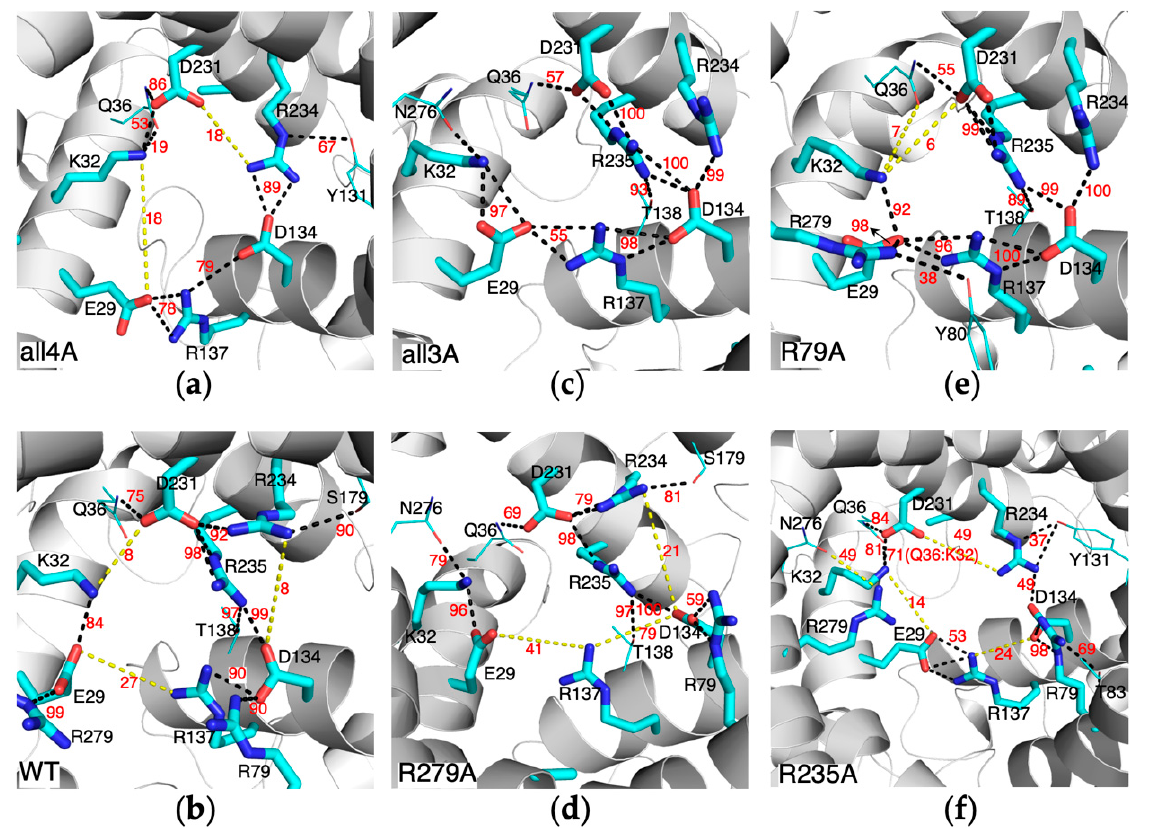
Figure 2. The m-gate electrostatic network in the various mutants (a,c – f) and wild-type (b) of apo AAC. Yellow dash lines are added manually to indicate the salt bridges and H-bonds that do not appear in the shown snapshots. Salt bridges or H-bonds with the occupancies lower than 5% are not shown. For mutants, occupancies of salt bridges and H-bonds are calculated on each trajectory from 200 ns to 1 μ s. The occupancies in the wild-type AAC were averaged over last 2 μ s of the three 3- μ s trajectories. To assess the effect of introducing R79 to the above all3A-AAC mutant, the R279A-AAC mutant was built in which both R279 and K22 of AAC were mutated to alanine. The MD simulations show that the presence of R79 lifts up D134 through forming the D134:R79 salt bridge. This does not change the strong D134:R235 salt bridge but deteriorates the D134:R234 salt bridge. R234 changes the orientation to bind with D231 and S179